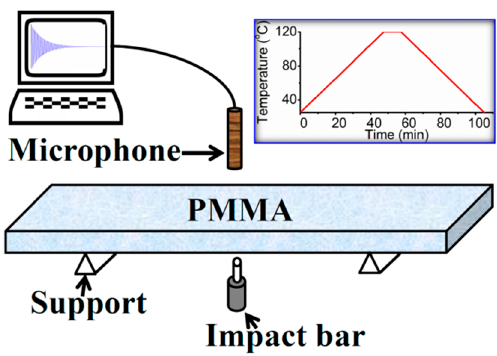
Figure 1. Schematic picture of the setup of impulse excitation test and the temperature profile (inset).